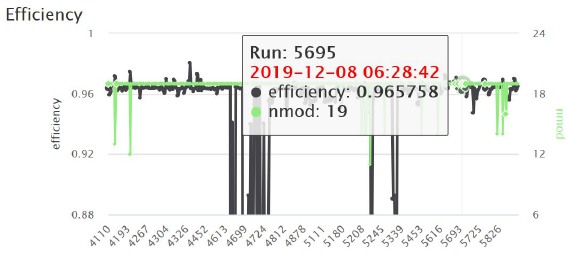
Figure 4. Run-by-run comparison for PXD e ffi ciency. Highlighted run 5695, 8 December 2019.